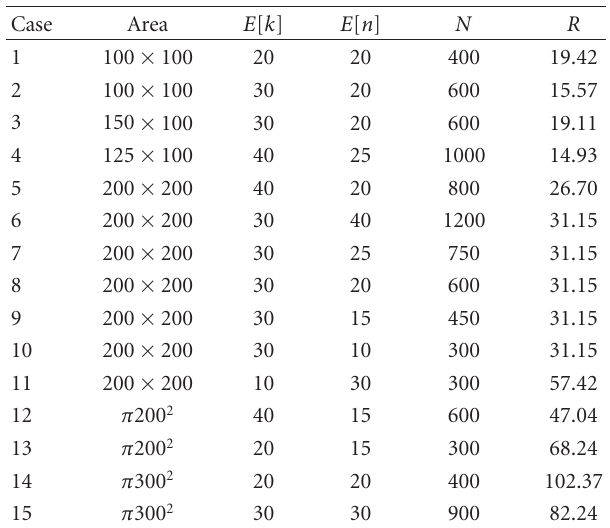
Table 3: Network deployment requirements.